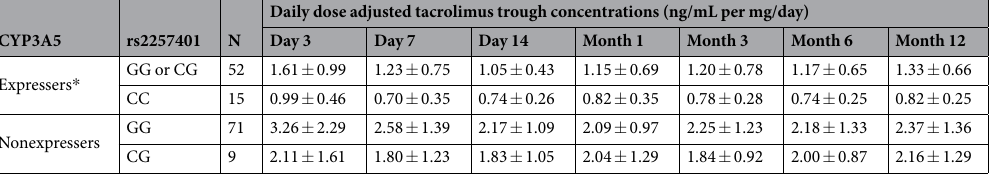
Table 3. Tacrolimus dose-adjusted trough concentrations in CYP3A7 rs2257401 genotypes classified by different patients expressing CYP3A5 . Data are presented as a mean with standard deviation. * P < 0.05 analyzed by a mixed effect model after adjusted by patient age, serum albumin, and creatinine. CYP3A5 expressers are carriers with CYP3A5 * 1/ * 1 or CYP3A5 * 1/ * 3